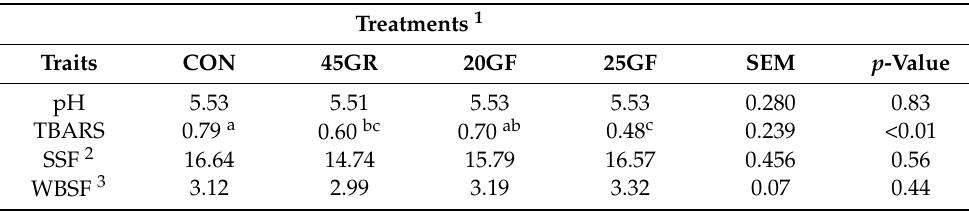
Table 2. Least square means for pH, thiobarbituric acid reactive substances (TBARS), and shear force values of steaks from cattle with different treatments stored in the retail display case at 4 ◦